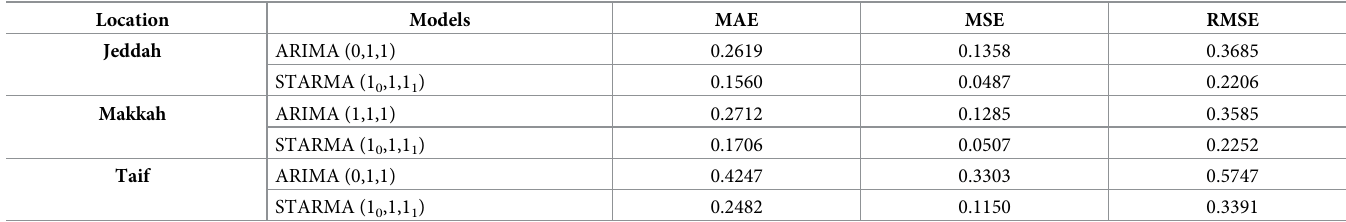
Table 6. Accuracy measures of predictive power for ARIMA and STARIMA